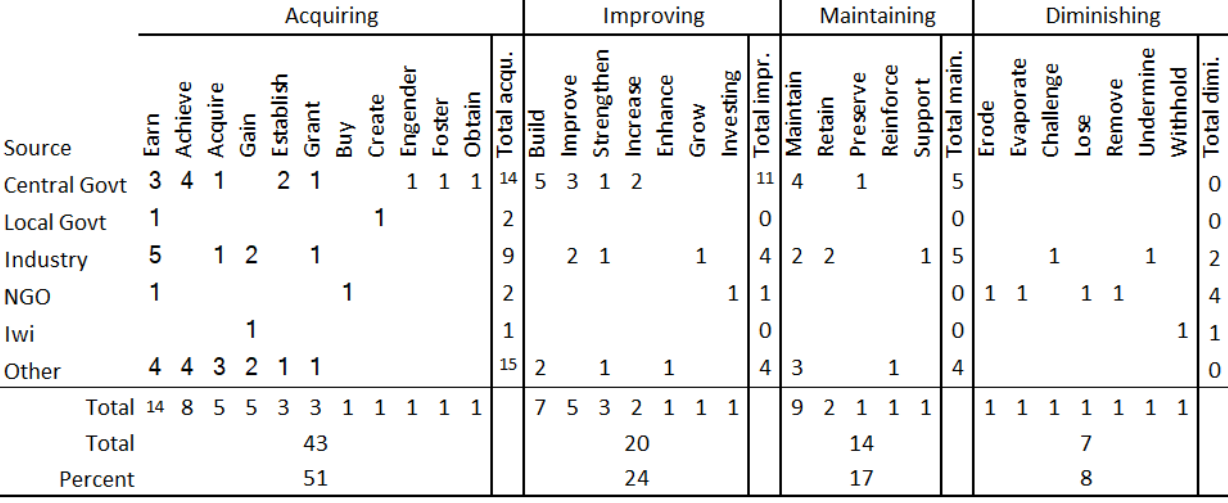
Fig. 4 . Status of social license to operate (SLO) as implied by material process verbs by